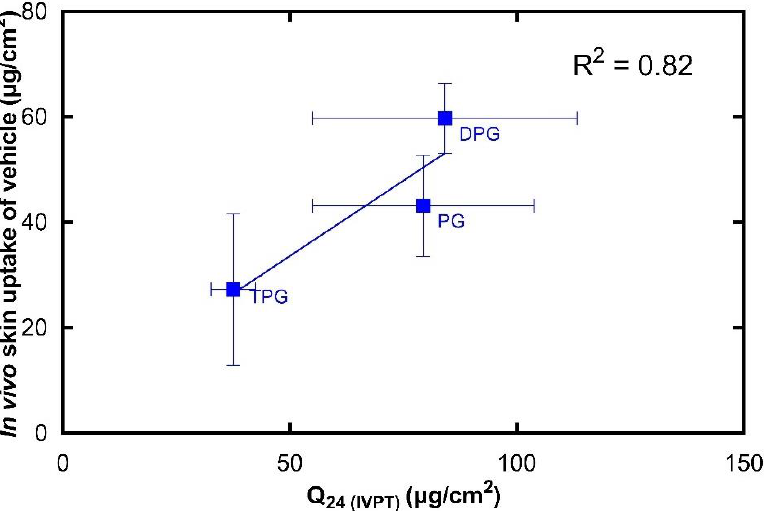
Figure 10. Correlation of the in vitro cumulative amount of vehicle permeated after 24 h (mean ± SD, n = 5) and the total amount of vehicle in the SC per skin surface area in vivo (mean ± SD, 4 ≤ n ≤